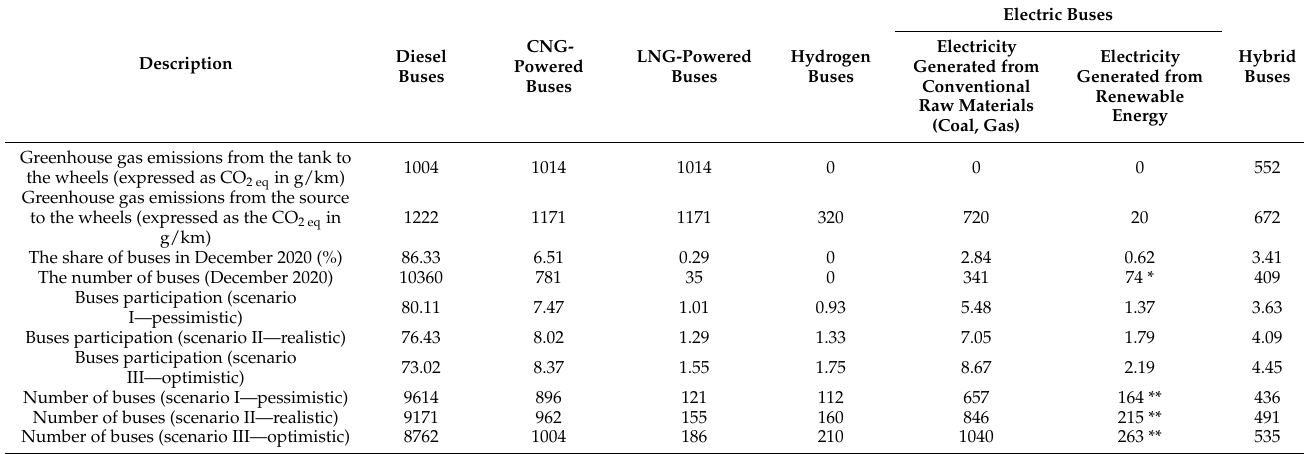
Table 5. Greenhouse gas emissions and number of buses for scenarios I-III